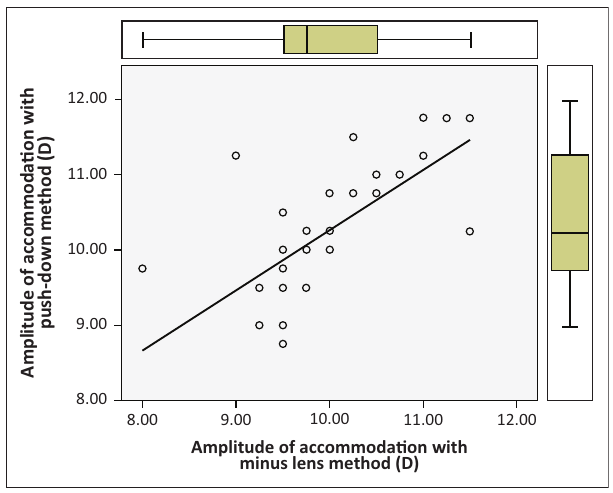
The least-square-fitted black line: y = 2.3 + 0.8 (minus lens method). The correlation r = 0.67. FIGURE 5: Correlation between the amplitude of accommodation measured with the push-down method versus the amplitude of accommodation measured with the minus lens method.